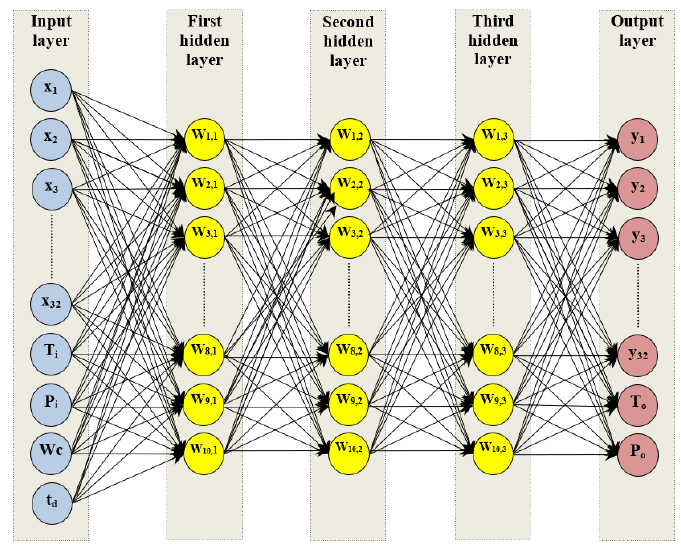
Figure 3. Optimum topology of artificial neural network model.